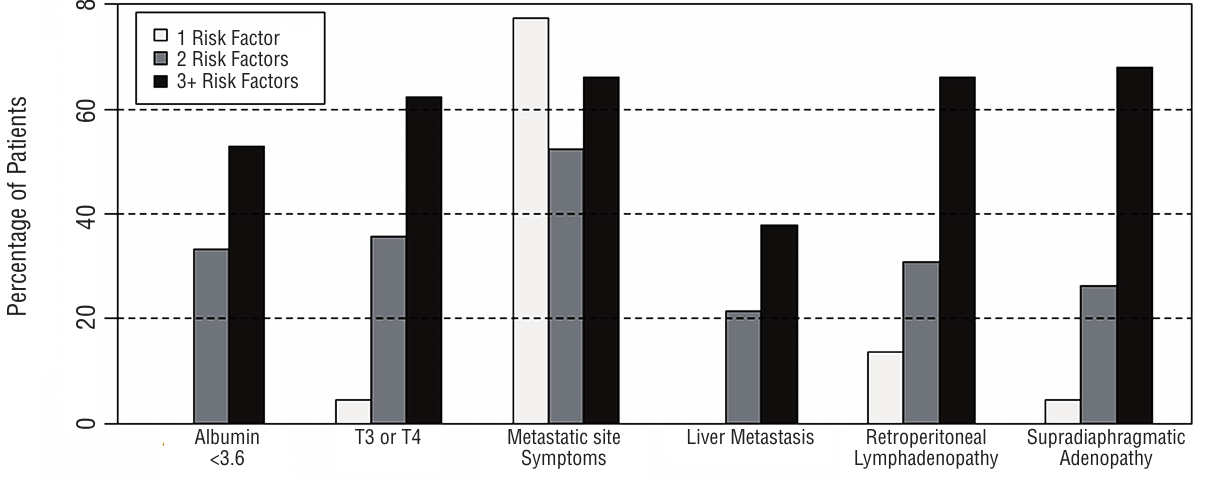
figure 1 - Distribution of individual risk factors among patients stratified by total number of risk factors